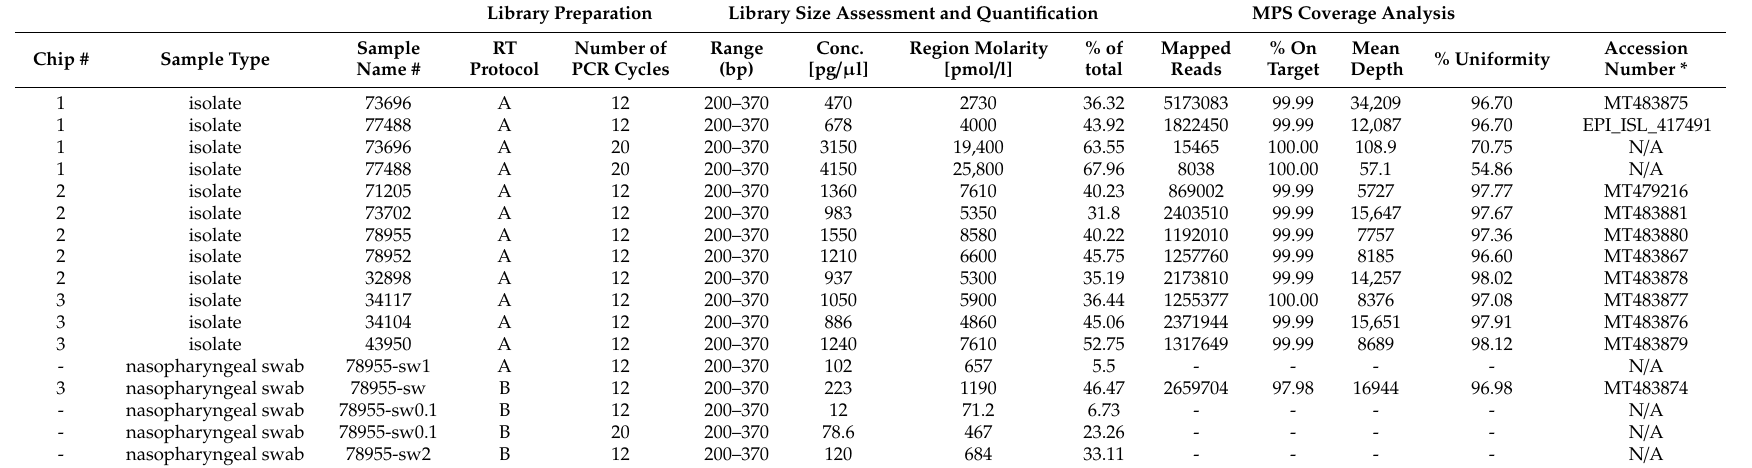
Table 1. Analytical conditions and results of the fourteen SARS-CoV-2 libraries analysed in this